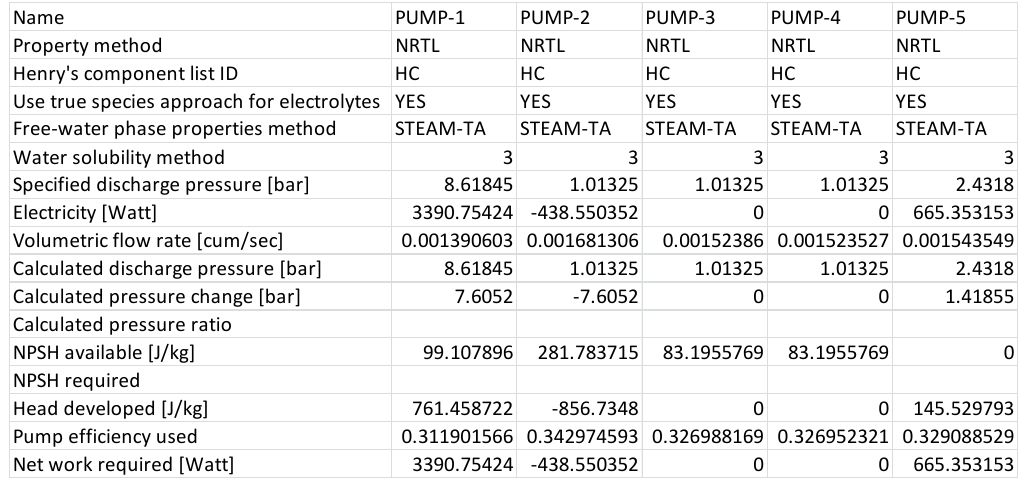
Figure A14. Fermentation heat exchanger results.